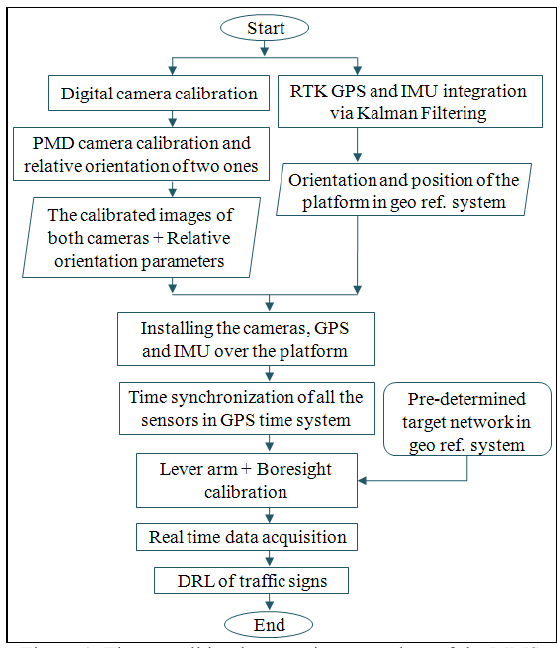
Figure 1. The overall implementation procedure of the